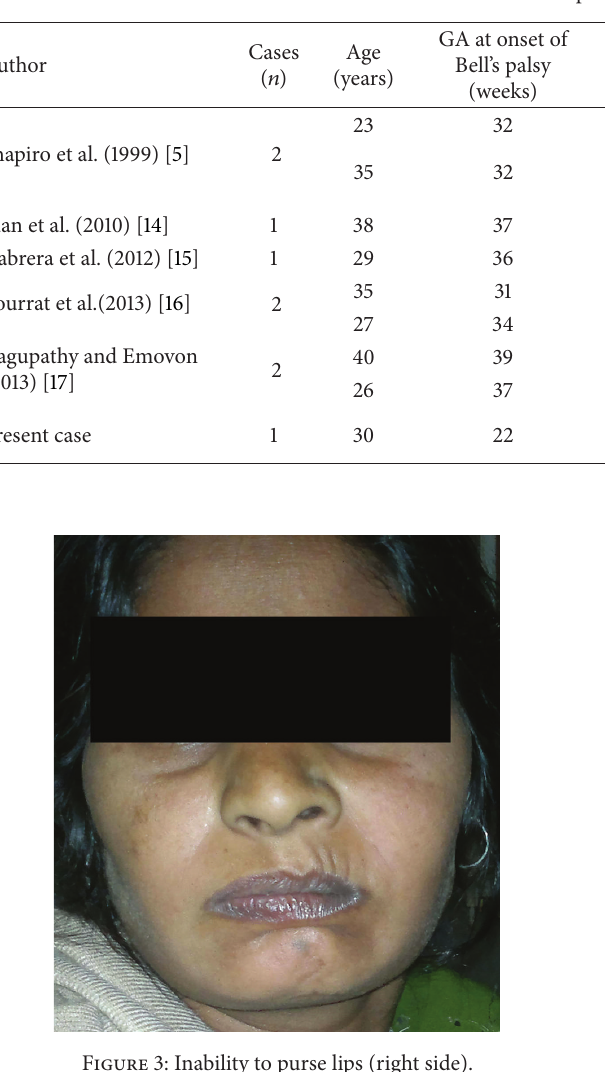
Figure 3: Inability to purse lips (right side).